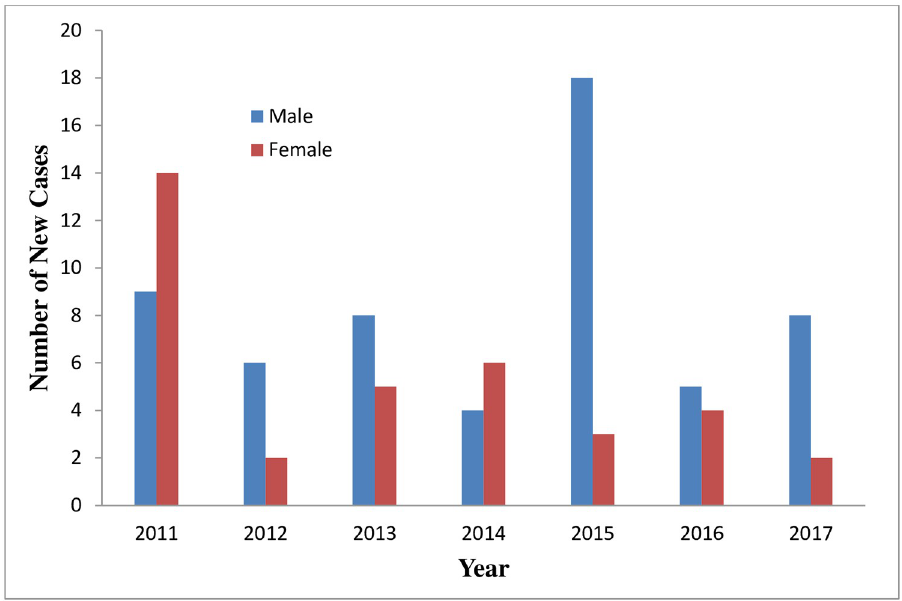
Fig 1. Annualised distribution of new cancer